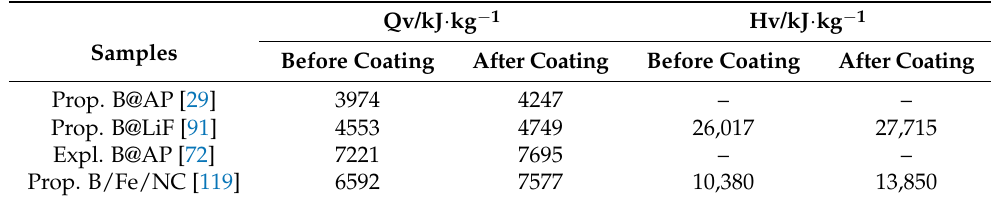
Table 5. Detonation heat (Qv) and combustion heat (Hv) of coated boron